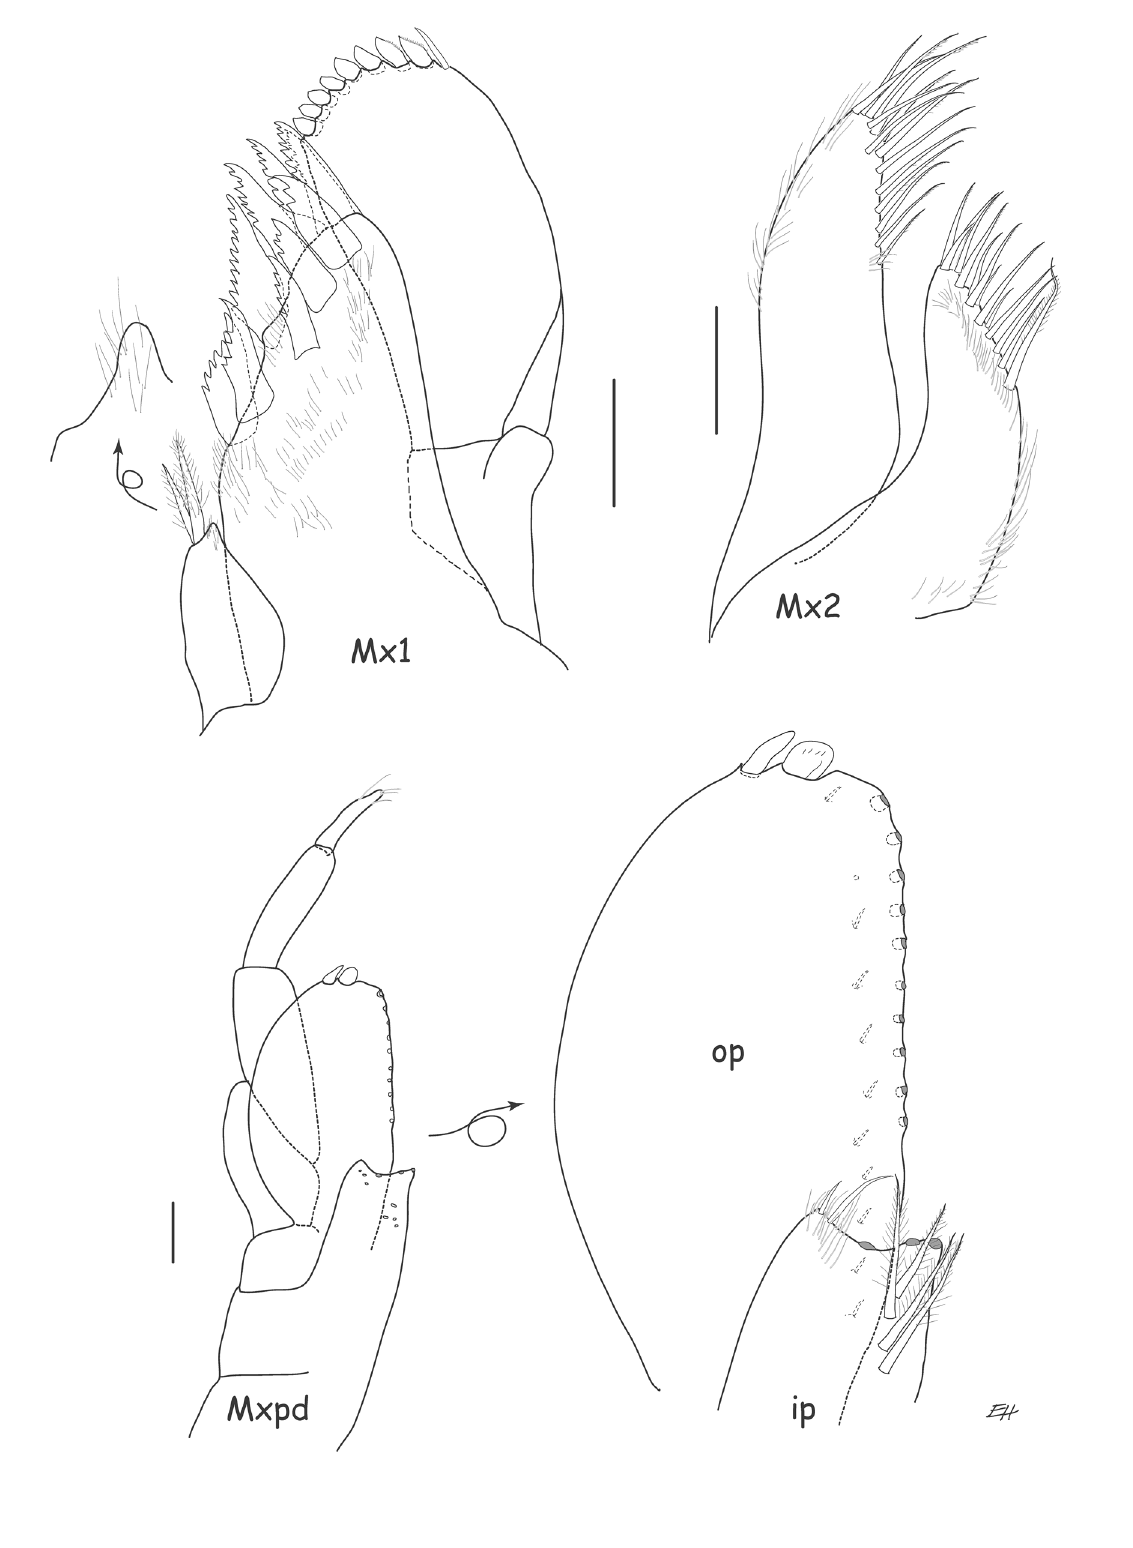
Fig. 7. Abyssorchomene abyssorum (Stebbing, 1888), holotype, ♂, 7.5 mm (BMNH 1889.5.15.23). Setae omitted on Mxpd. Scale bars = 0.1